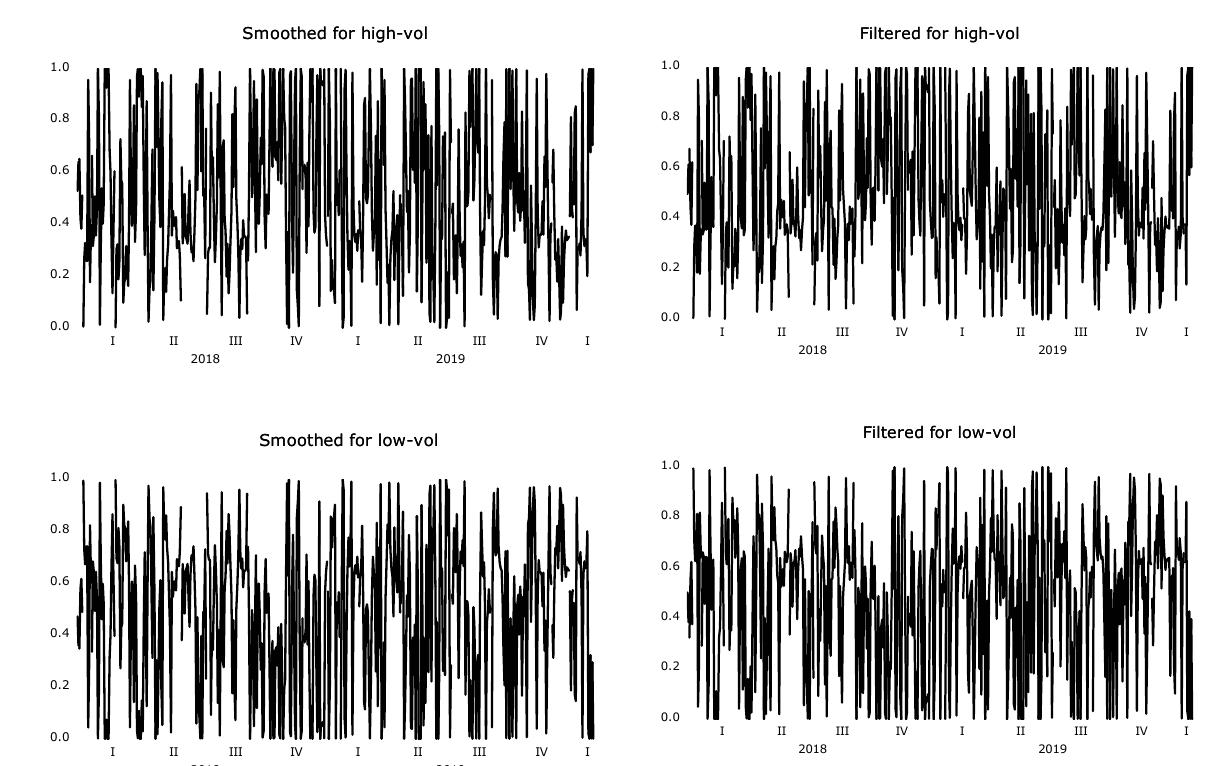
Figure 10. Computed smoothed probabilities and filtered conditional volatilities for XSD.